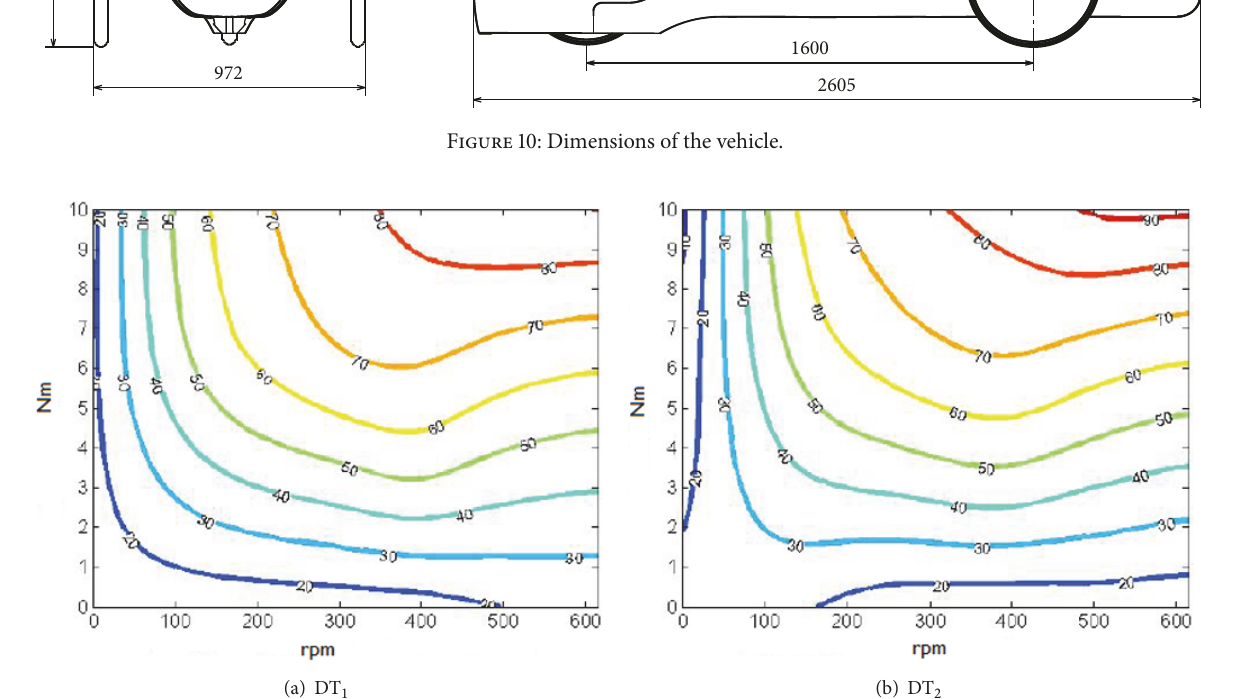
Figure 11: Maps of the efficiency of tested drivetrain systems.